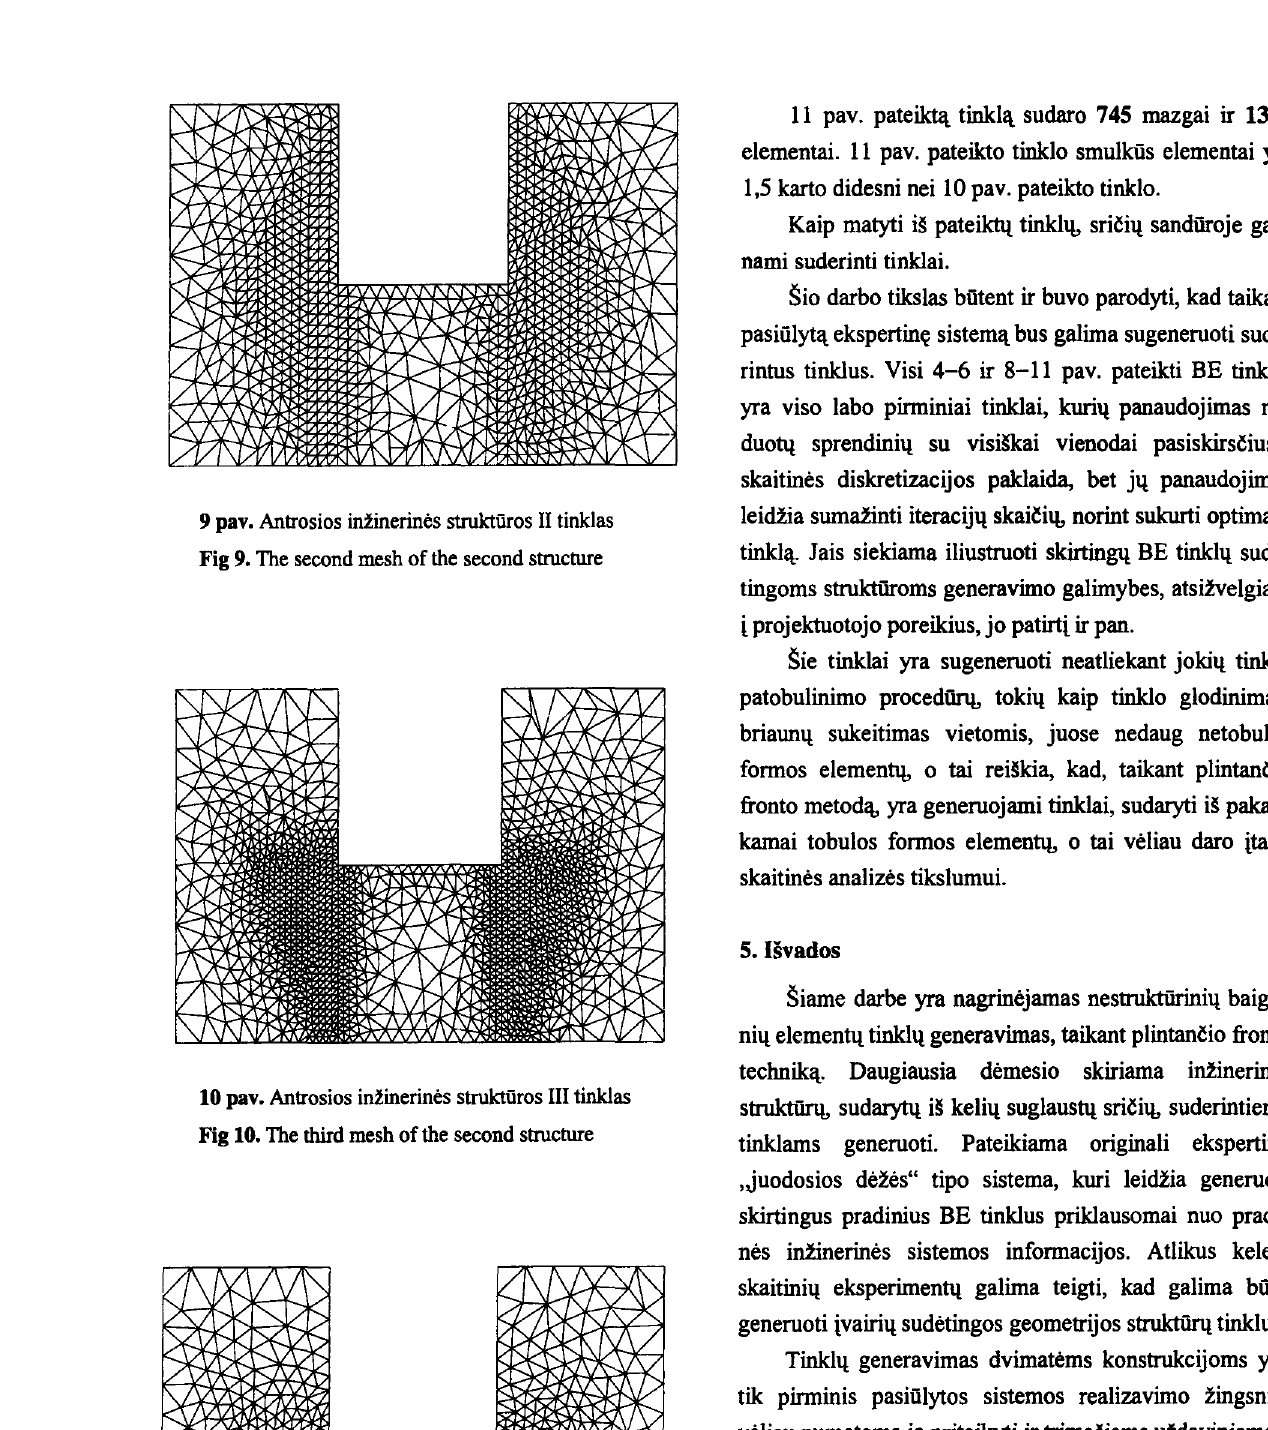
11 pav. Antrosios in!inerines struktiiros IV tinklas Fig 11. The fourth mesh of the second